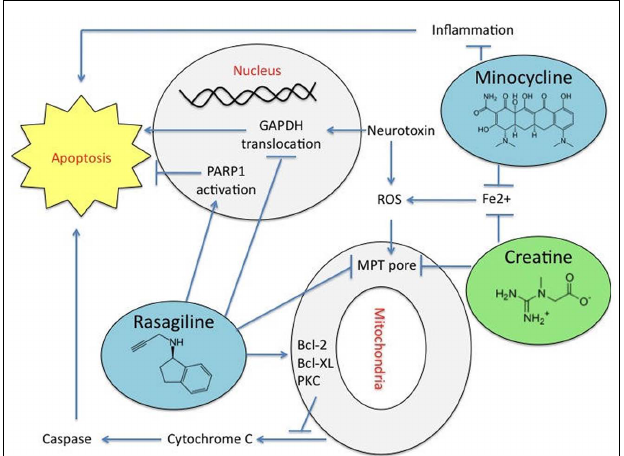
FIGURE 1 |The mechanisms of action of neuroprotective agents that are in clinical trials. Rasagiline shows neuroprotective properties by suppressing mitochondrial apoptosis stopping the mitochondrial permeability transition pore (MPT) opening by inhibiting caspase-3, nuclear poly [ADP-ribose] polymerase 1 (PARP-1) activation, stopping the translocation of glyceraldehyde-3-phosphate dehydrogenase (GAPDH), and halting nucleosomal DNA fragmentation. Rasagiline increases the expression of the anti-apoptotic proteins B-cell lymphoma 2 (Bcl-2) and B-cell lymphoma-extra large (Bcl-xL) through the protein kinase C (PKC) pathway, in addition to down-regulating the pro-apoptotic Bcl-2-associated death promoter (Bad) and Bcl-2-associated X protein (Bax). Minocycline inhibits the inflammatory response to prevent cell death and it chealates metals. Creatine inhibits activation of the MPT and represses iron (Fe 2+ )